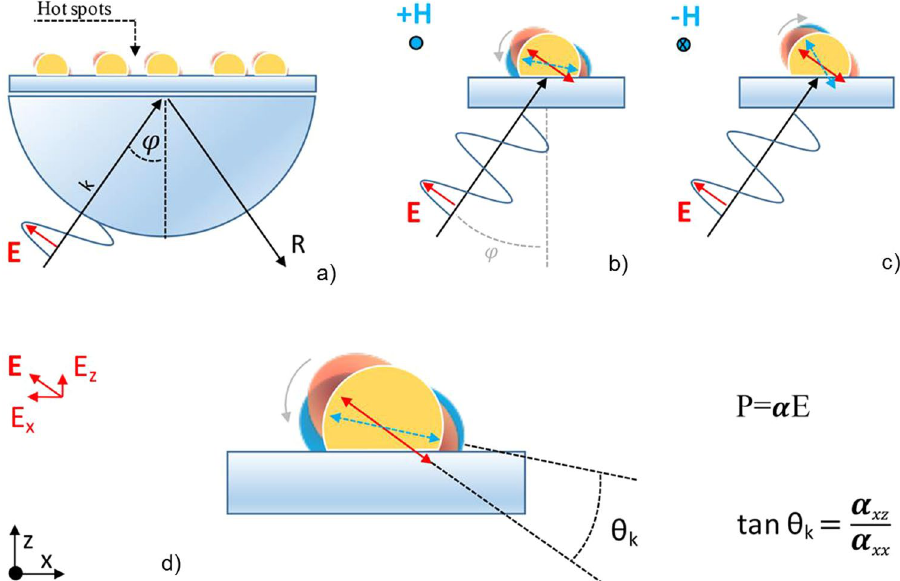
Figure 6. ( a ) Hot spots generate by polarized incident light onto the nanostructured material. Schematic of the MO effect induced by the Lorentz force in metal nanoparticle, ( b ) before and ( c ) after the application of an oscillating magnetic field in transversal configuration. ( d ) Schematic representation of the torque suffered by the oscillating electrical dipoles due to the magnetic field application causing the switch-off of the hot spots in the plane of the